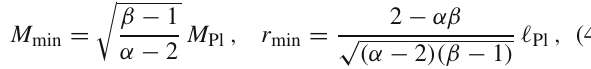
= r (cid:6) then S C